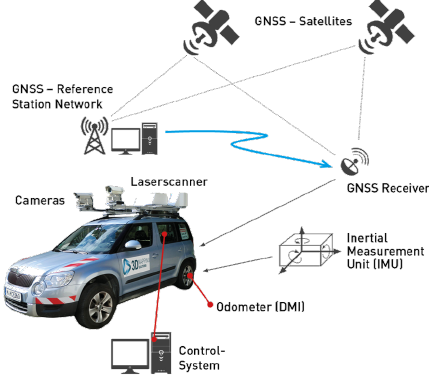
Figure 1. High precission mobile mapping system and sensors used (3D Mapping Solutions GmbH) features are extracted for appropriate representation of the local geometry, followed by removal of the effect of local tendency for each supervoxel in order to enhance distinction between similar structures. And lastly, Random Forests (RF) algorithm is applied for assigning labels to supervoxels and points within them. 2) Deep learning approach is employed through semantic segmentation of MMS images of the same scene. To achieve this, Pyramid Scene Parsing Network (Zhao et al., 2017) is